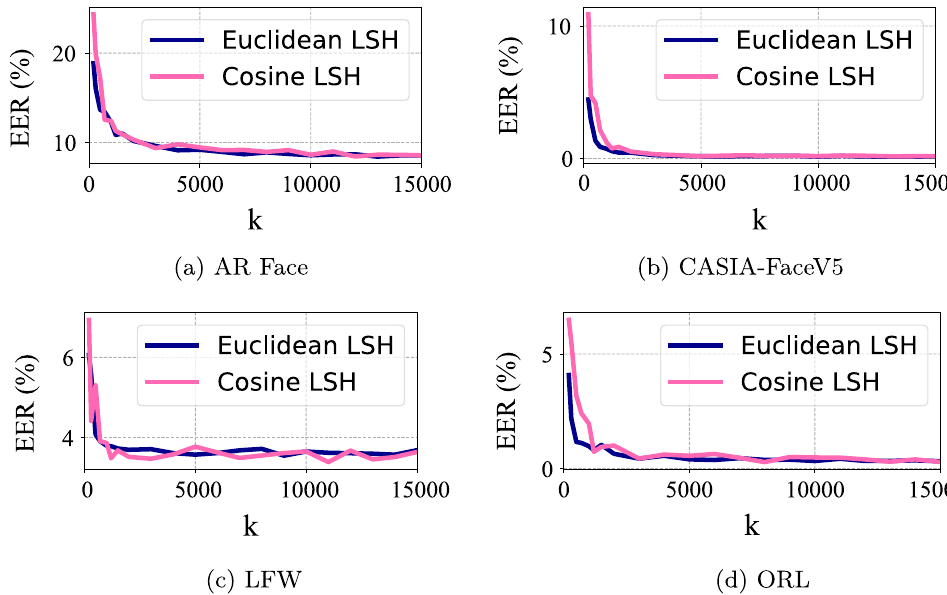
Fig. 7 EER changes with LSH length k under c = 1.0 , d = 2 and N =